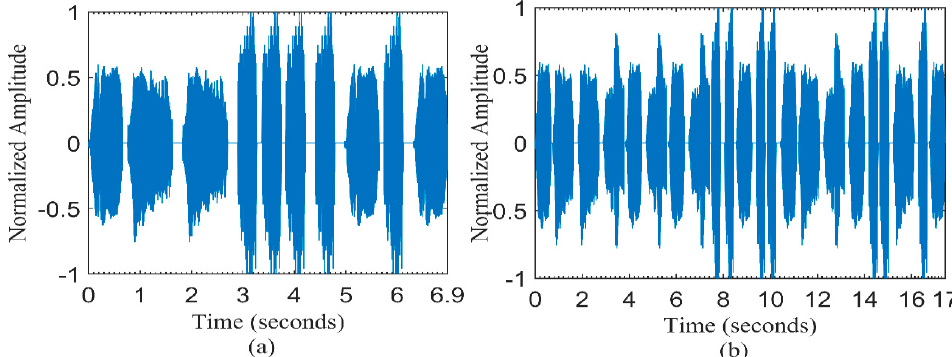
Figure 5. A mimicked signal through a humpback whale song using bionic codes representing ( a ) COVERT ( b )